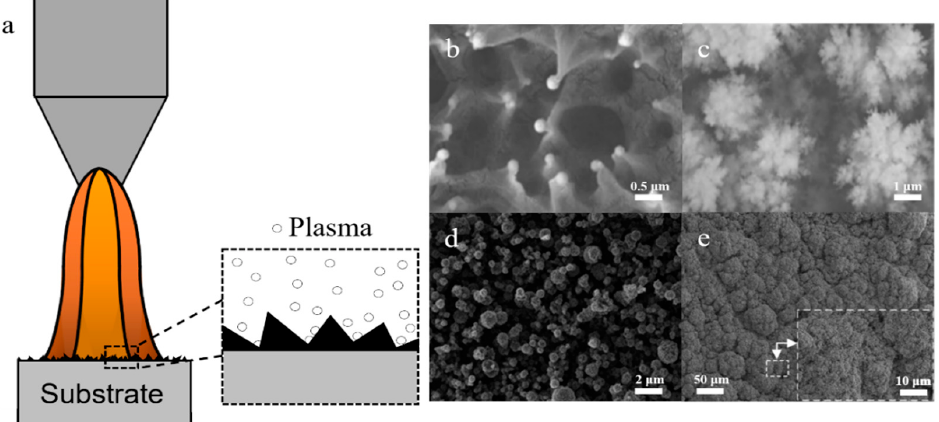
Figure 9. ( a ). Principle of plasma treatment; ( b ) coronary [50]; ( c ) dendritic [51]; ( d ) ball [52]; (e) cauliflower [53].